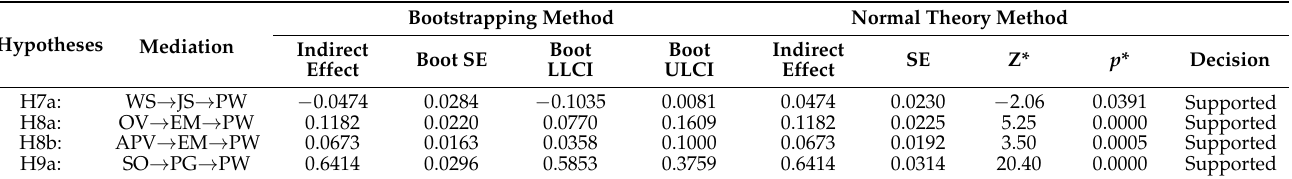
Table 8. Mediation